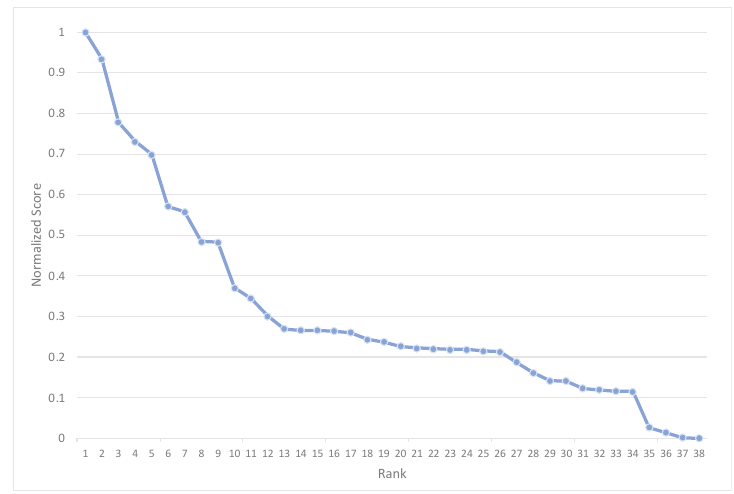
Figure 5. Rank-score functions of the cognitive diversity of the 38 test cases.